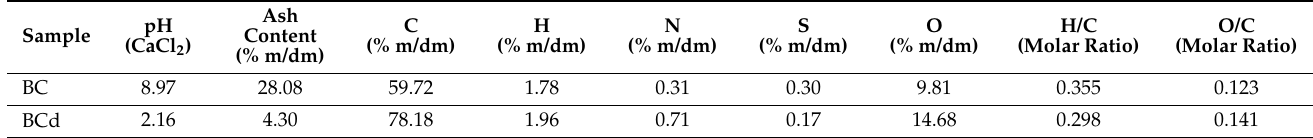
Table 1. Basic properties of pristine wheat-straw biochar (BC) and its deashed counterpart (BCd). Shares of the C, H, N, S and O elements are expressed in % weight per dry mass